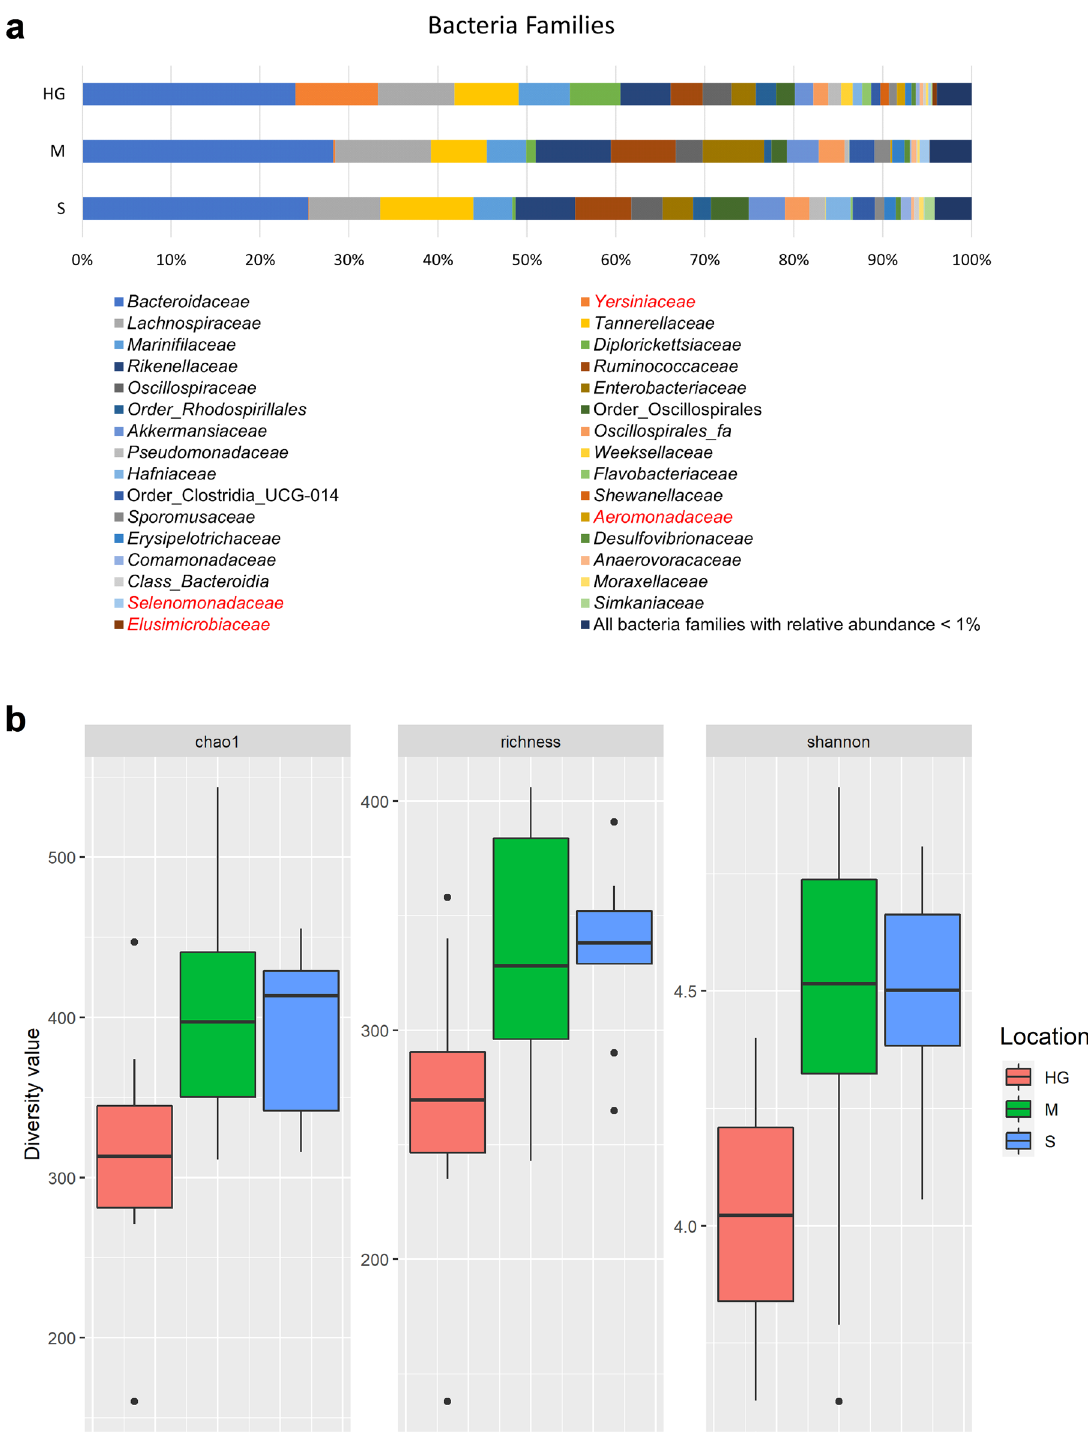
Figure 3. ( a ) Bacteria families found in the fecal samples of fire salamanders from forests HG (Heilig Geestgoed), M (Makegem), and S (Smetledebos). Bacteria families that are significantly different between locations are highlighted in red. ( b ) Alpha diversity indices of gut microbiome between different locations. Boxes are extended from the 25th to 75th percentiles, and the horizontal line inside the boxes defines the median. Whiskers indicate variability outside the upper and lower quartiles. Black circle indicates